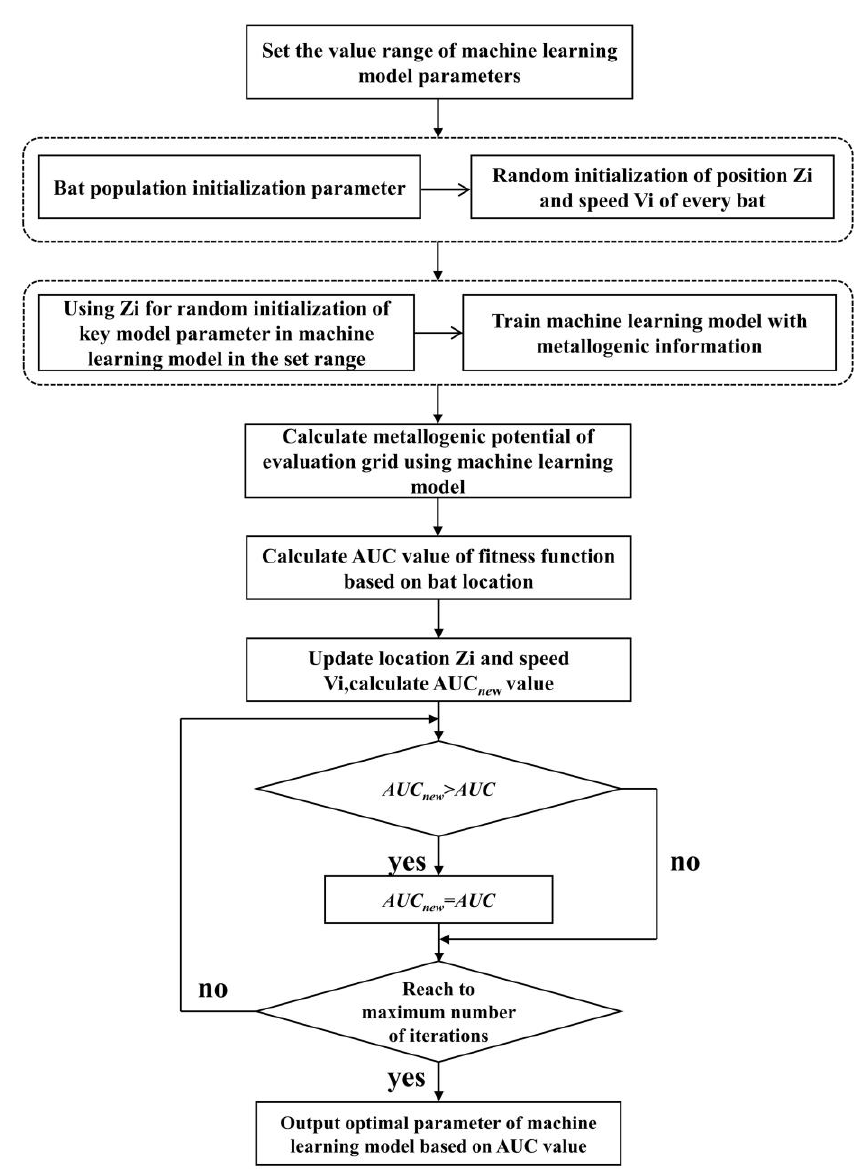
Figure 8. Bat algorithm (BA) optimization process.